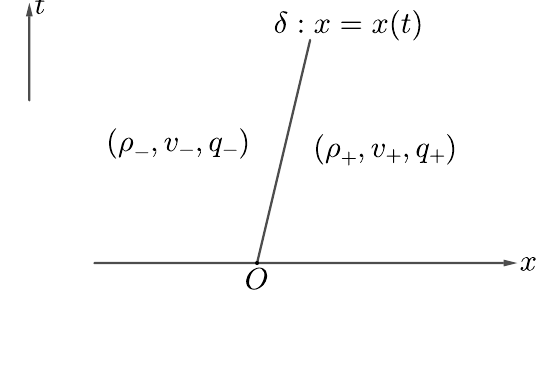
Figure 2: Riemann solution: δ